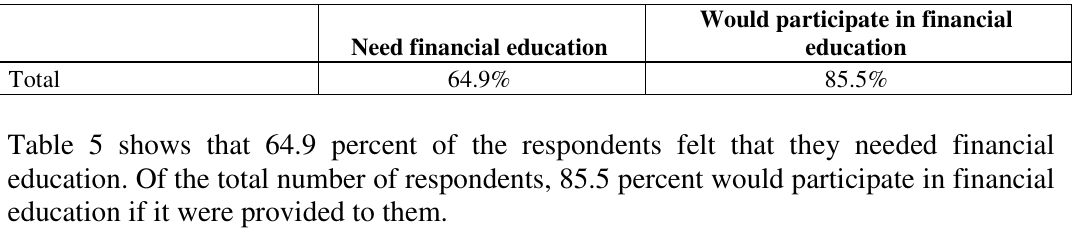
Table 5: The total respondents in need of financial education and participation